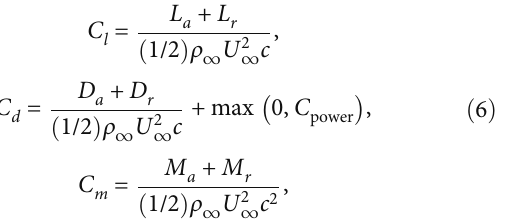
= 0 : 2 and C = 0 : 005 ∞ μ